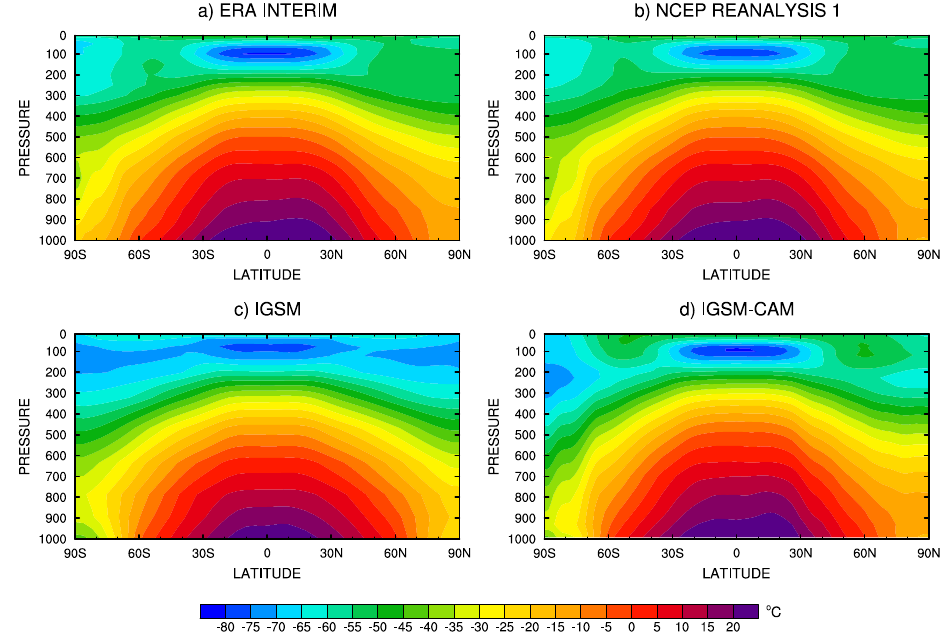
Fig. 4. Zonal mean vertical cross sections of present-day (1981–2010 period) temperature ( ◦ C) for the IGSM and IGSM-CAM simulations, under median climate sensitivity, and for the ERA-Interim and NCEP Reanalysis 1.